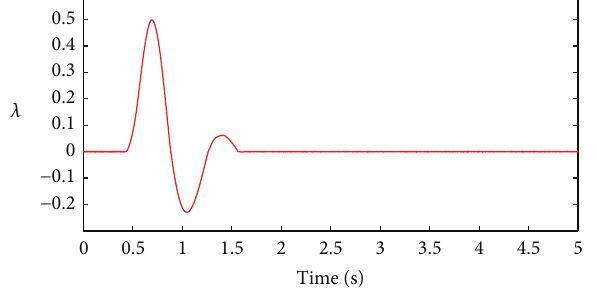
Figure 11: Estimate of 𝜆 (Case 2).